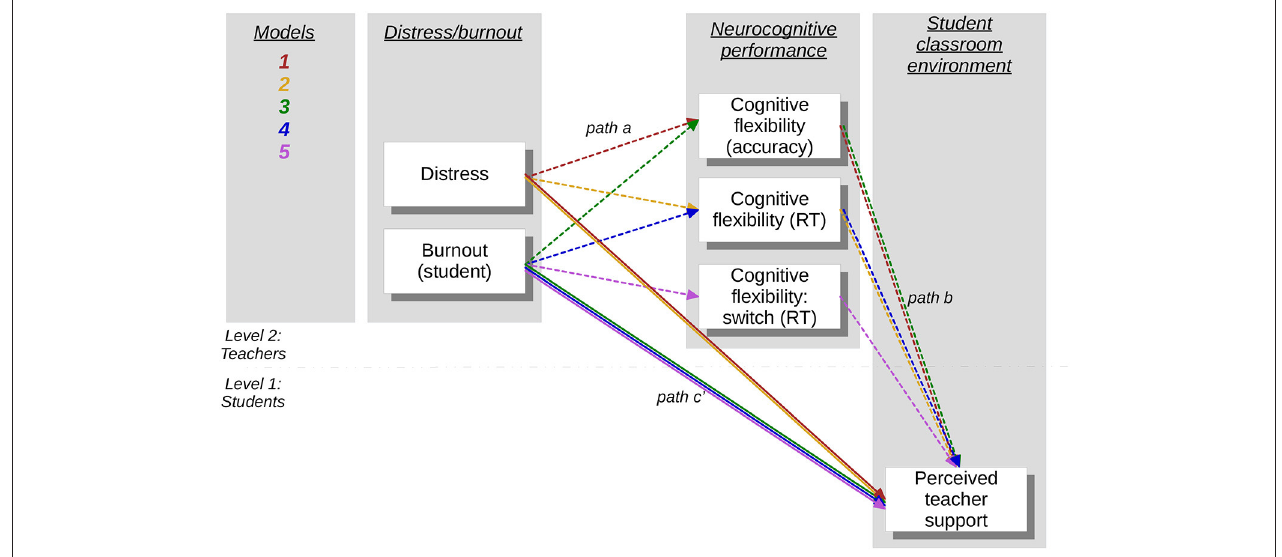
FIGURE 1 | Illustration of the 2-2-1 mediation models proposed, with each model uniquely colored. All variables included reflect the change from pre- to post- intervention measurements.